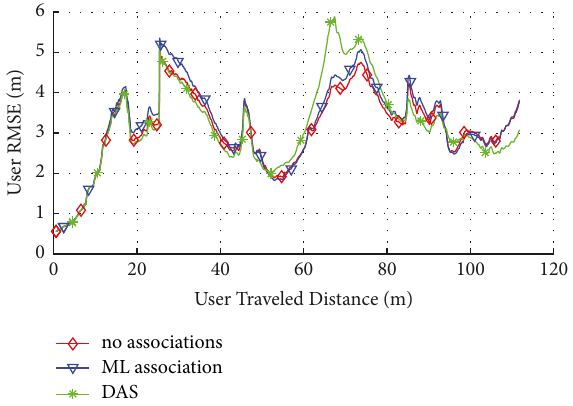
Figure 11: The RMSE of the user position versus the user traveled distance for the outdoor measurements. The red curve shows the RMSE if no associations among transmitters are made, the blue curve if the ML method for associations is applied, and the green curve for using